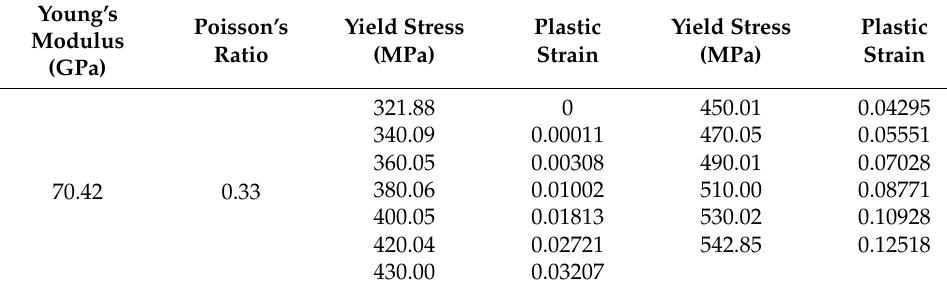
Table 2. Mechanical properties of 2024-T3 aluminum sheet